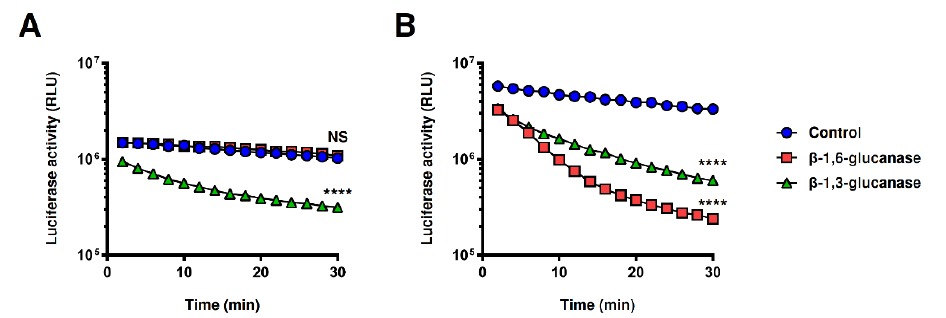
Figure 6. Real-time monitoring of side-chain structural changes of β -glucan using split-NanoLuc complementation assay. The mixture solution of ( A ) supBGRP-LgBiT and supBGRP-SmBiT or ( B ) supBGRP-LgBiT and Neg1-E321Q-SmBiT (200 nM each, 5 µ L) were incubated with 10 µ L of zymosan A (10 µ g/mL) for 60 min. After incubation, endo- β -1,6-glucanase or endo- β -1,3-glucanase (0.5 µ g/mL, final) was added with 15 µ L of furimazine solution, and reconstituted NanoLuc activity was measured 15 times every 2 min. Data are presented as the mean ± SD ( n = 4) and are representative results from at least two independent experiments. Significant differences relative to untreated (control) sample at 30 min (unpaired t -test) are represented as **** p < 0.0001; NS: not significant.